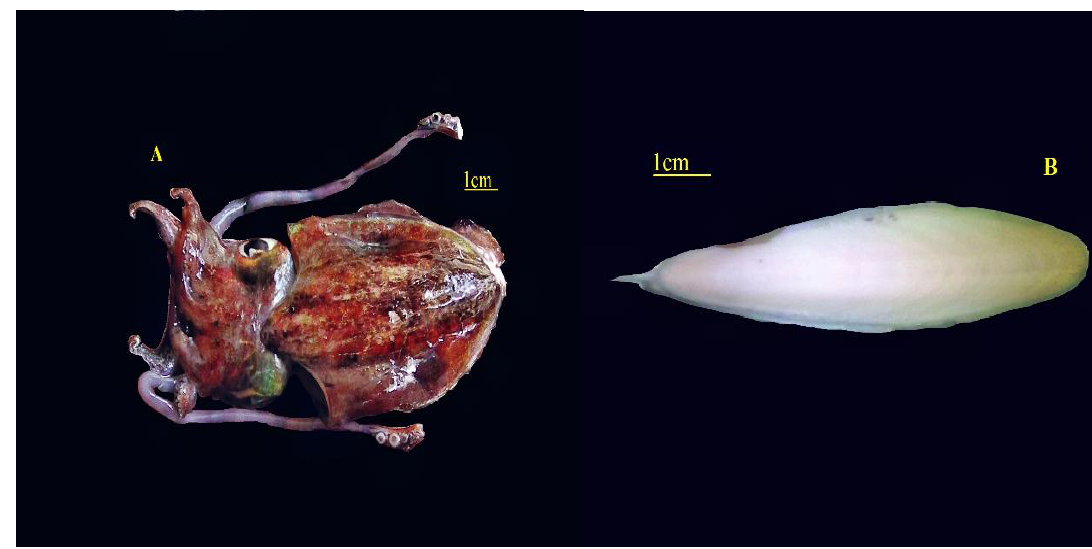
F IGURE 3. Joubiniteuthis portieri : dorsal view.